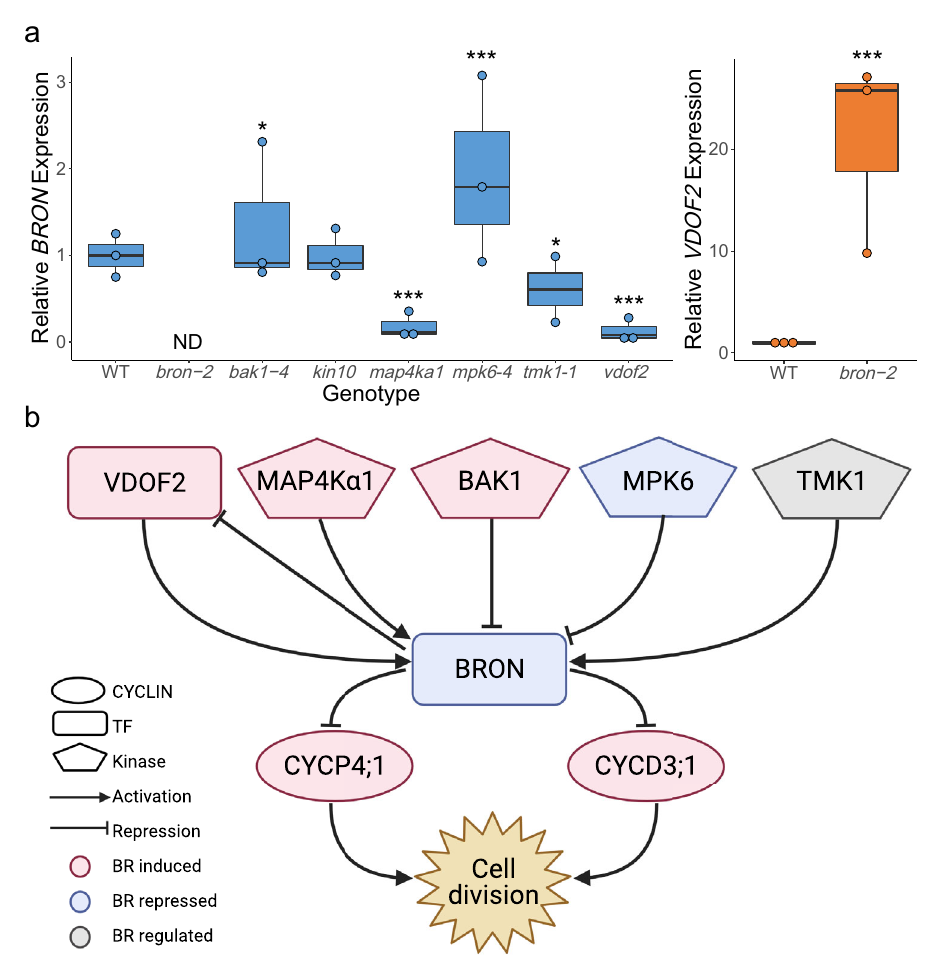
Fig. 5 BRON regulates cell division in response to BR. a RT-qPCR of BRON (left, blue) and VDOF2 (right, orange) in mutant lines. Reported values are 2 − ΔΔ C Τ . Centerline represents the median; box bounds represent 25th and 75th percentiles; whiskers represent minimum and maximum. Colored dots represent the average of two technical replicates for each biological replicate ( n = 3 except for tmk1-1 , where n = 3 were assayed but BRON was detected in only n = 2). ND: not detected. * denotes p < 0.05, *** p < 0.0001 using two-tailed z test compared with mean and standard deviation of WT. Multiple testing correction was not performed. b Proposed model for the role of BRON in BR response. The BR-responsive kinases MAP4K α 1, BAK1, MPK6, and TMK1 regulate BRON . In addition, BRON and VDOF2 regulate each other in a negative feedback loop. The coordination of these upstream regulators results in the repression of BRON after BL treatment. This repression of BRON lifts its repression on the cyclins CYCD3;1 and CYCP4; 1, leading to BR-induced cell